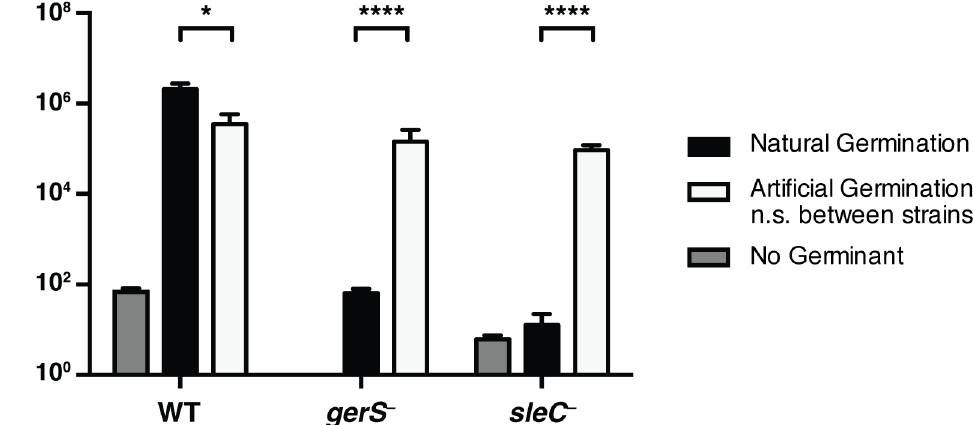
Fig 5. Artificial germination of gerS − bypasses its germination defect. Wildtype, gerS − , and sleC − spores were incubated with no germinant, taurocholate (natural germination) or thioglycollate and lysozyme (artificial germination). Mutants defective in cortex hydrolysis can be artificially germinated [58]. Data represents the average of 4 biological replicates. No statistical significance was observed between strains subjected to artificial germination, in contrast with natural germination. Statistical significance was determined using ANOVA and Tukey ’ s test ( * p < 0.05; **** p < 0.001).